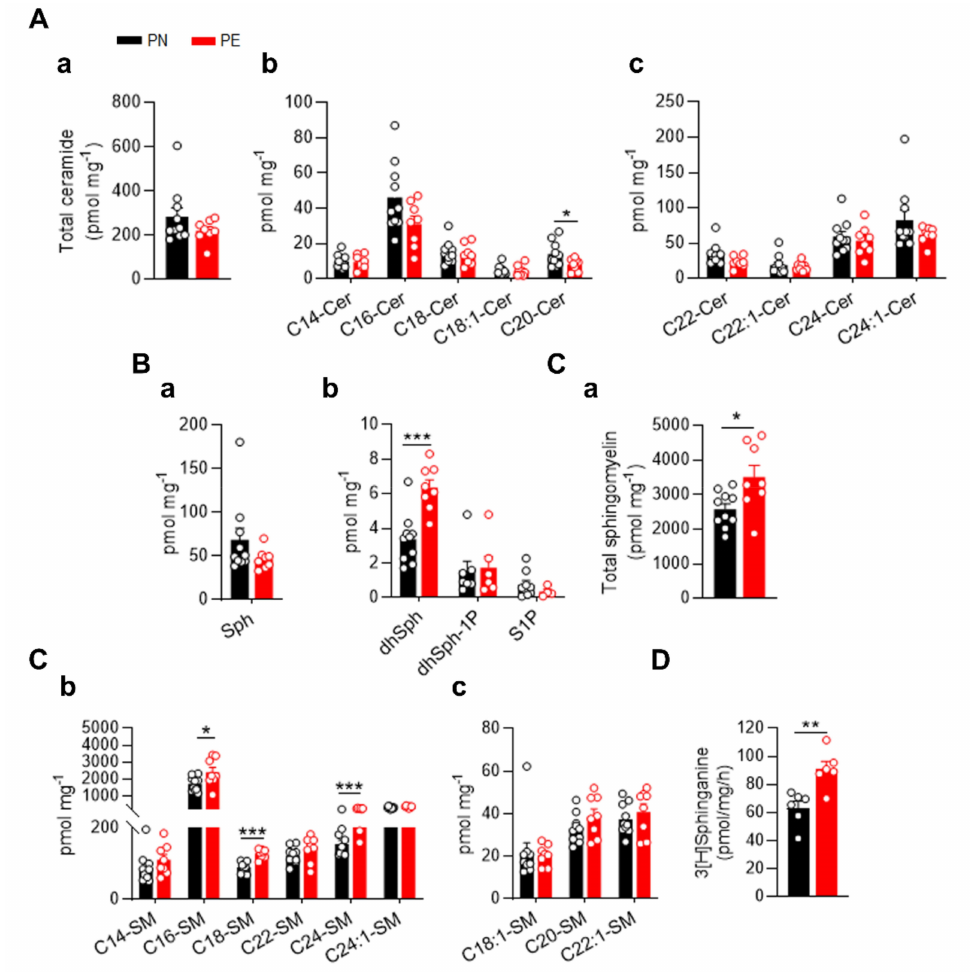
Figure 1. Sphingolipids content and serine palmitoyltransferase (SPT) activity of normotensive (PN) and preeclamptic (PE) chorionic arteries. LC-MS quantification of ceramide ( A ), sphingosine intermediates ( B ), and sphingomyelin ( C ) of isolated placental chorionic arteries from normotensive ( n = 10) and preeclamptic women ( n = 8). Total ( A , a ) and individual ( A , b ; A , c ) ceramide species. ( B ) Dihydrosphingosine (dhSph), sphingosine (Sph), dihydrosphingosine -1-phosphate (dhSph-1P), and S1P. Total ( C , a ) and individual ( C , b ; C , c ) sphingomyelin species. ( D ) Chorionic arteries lysates were assessed for SPT activity. [3H]-serine and palmitoyl-CoA were used as substrates by SPT to generate 3-ketosphinganine, subsequently reduced to sphinganine, followed by TLC separation. Sphinganine was used as the marker ( n = 6 per group). Data are expressed as mean ± SEM * P < 0.05; ** P < 0.01 *** P < 0.001 compared to PN. Statistical significance was determined by unpaired t